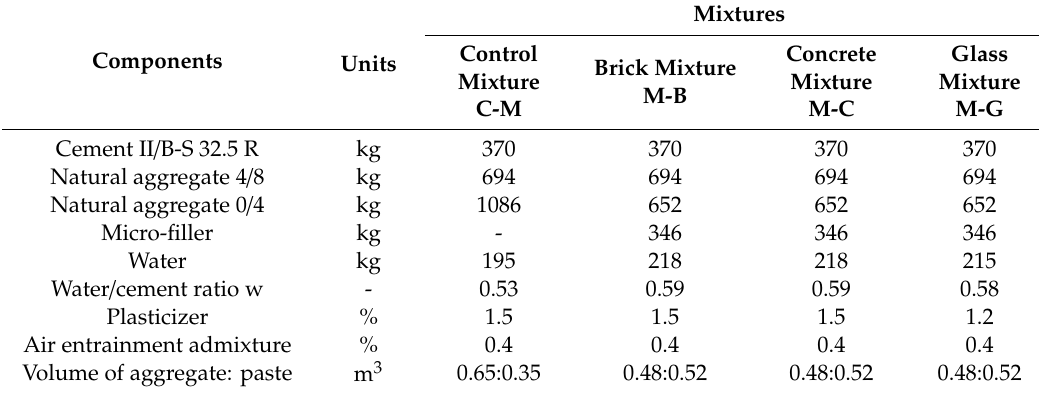
Table 2. Mixture